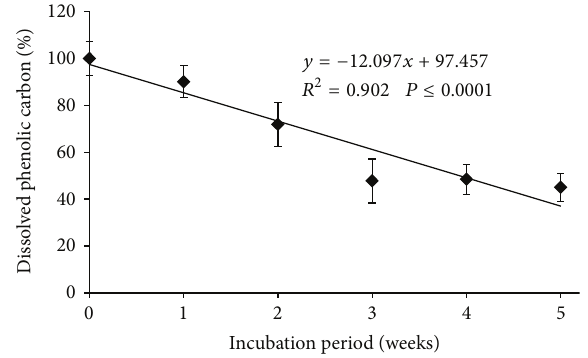
Figure 4: Effect of the decomposition period of A. compressus on percent dissolved phenolic carbon. The error bars are standard deviations of the three